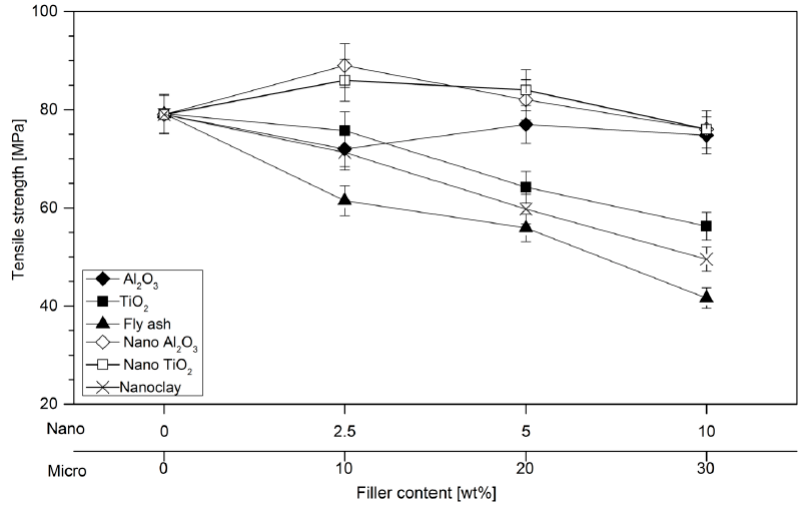
Figure 42. Tensile strength of epoxy resin based micro/nanocomposites versus filler content (Reprint with the permission of Strojniski vestnik–Journal of Mechanical Engineering [191]).